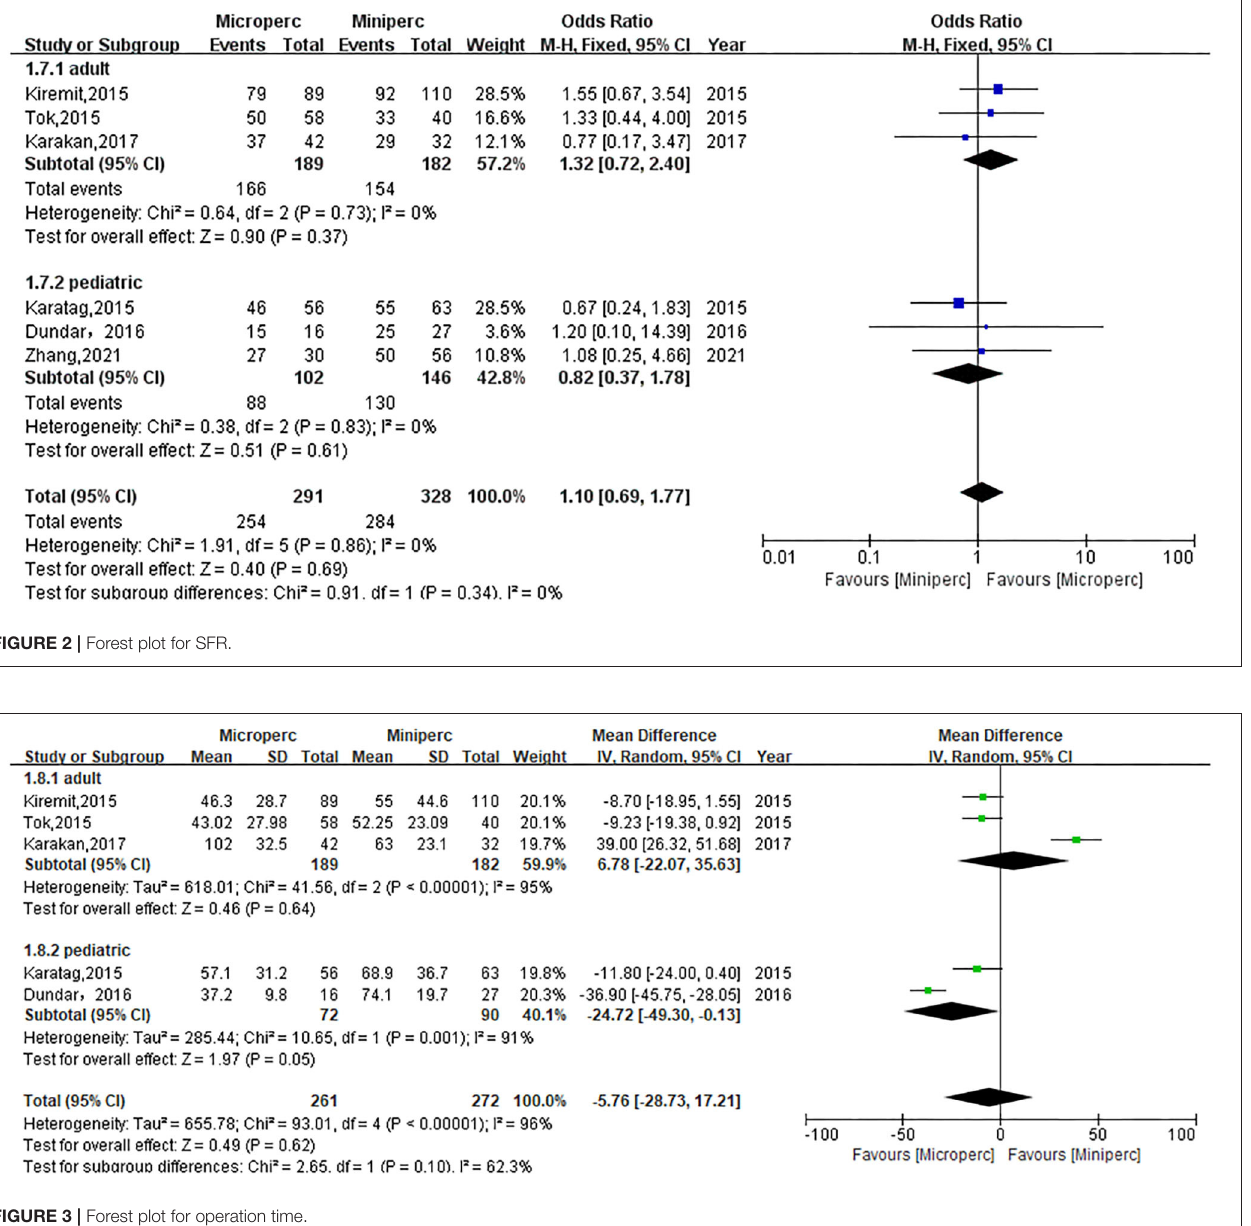
FIGURE 3 | Forest plot for operation time.